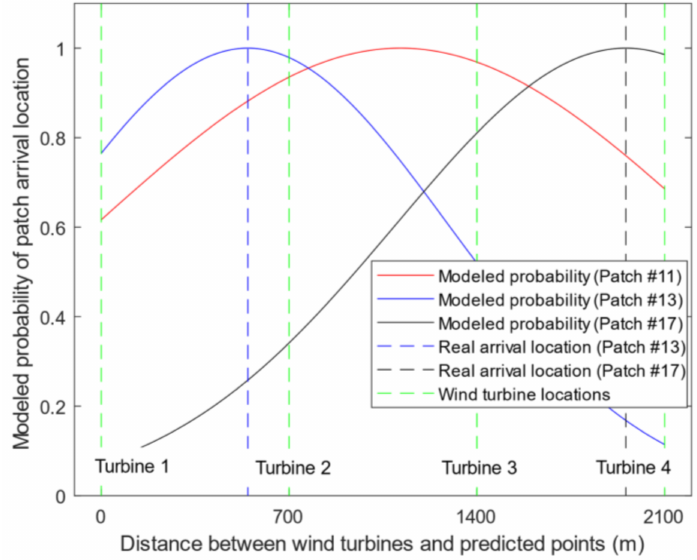
Figure 10. Real and predicted arrival positions, and predicted normalized spanwise distribution probability of the gusts. The patch numbers correspond to the gust numbers in Figure 5c. Green dash lines indicate the locations of the wind turbines relative to Turbine 1, and the distance is measured along the wind turbine array. The blue and black dash lines represent the real arrival positions of Patch 13 and 17, respectively. Since Patch 11 disappeared before arriving any wind turbine, no line indicates its real arrival location in the